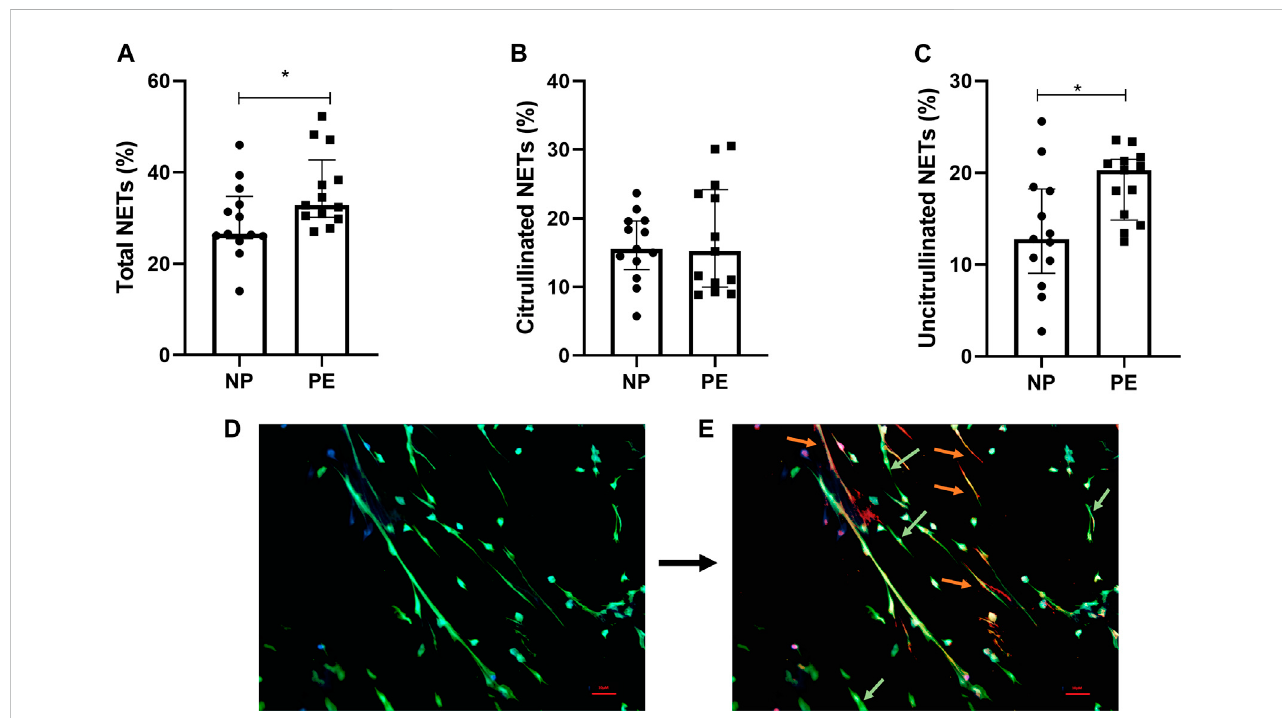
FIGURE 2 Percentage of total NETs (A) , citrullinated NETs (B) and uncitrullinated NETs (C) formed after stimulation of healthy volunteer neutrophils with plasma frompregnantwomendeliveringanormalpregnancy(NP)andplasmafromwomendeliveringwithpreeclampsia(PE). (A) TotalNETsfromNP,26.54%[25.48; 34.70]; from PE 32.79% [30.17; 42.70]. (B) Citrullinated NETs from NP, 15.56% [12.52; 19.63]; from PE, 15.23% [9.97; 24.20]. (C) Uncitrullinated NETs from NP, 12.80% [9.05;18.23];fromPE,20.26%[14.87;21.47].Resultsarerepresentedwiththeirmedians andinterquartile ranges[Q1;Q3]* p < 0.05. Photos taken by fl uorescence microscopy with the Olympus BX 60 microscope (Cytovision ® 7.5. software, Leica Biosystems), magni fi cation ×20. (D) DAPI (blue fi lter) marking DNA and anti-myeloperoxidase antibody (green fi lter) marking the granular content of neutrophils. Visualization of total NETs. (E) Addition of